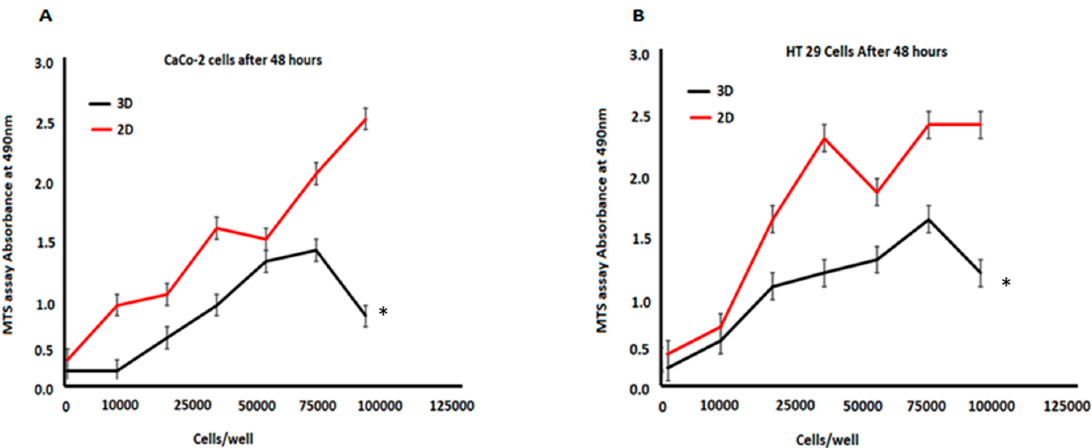
Figure 2. Results of the MTS assay for cell proliferation in 3D cultures and 2D cultures. ( A ) Caco-2 cells; ( B ) HT-29 cells developing in a 3D culture compared with the 2D culture (determined at 48 h). The initial cell numbers varied between 10,000 and 100,000 cells/well for Caco-2, and for HT-20, it ranged from 10,000 to 100,000 cells/well. Data are represented as mean ± SD; * p < 0.05 was considered significant between 3D and 2D cell models.